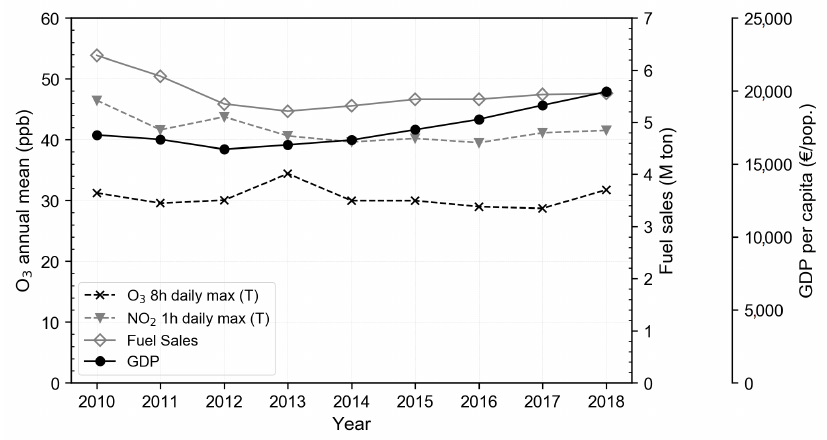
Figure 8. Lisbon traffic O 3 annual mean versus GDP and fuel sales (data on supplementary files).